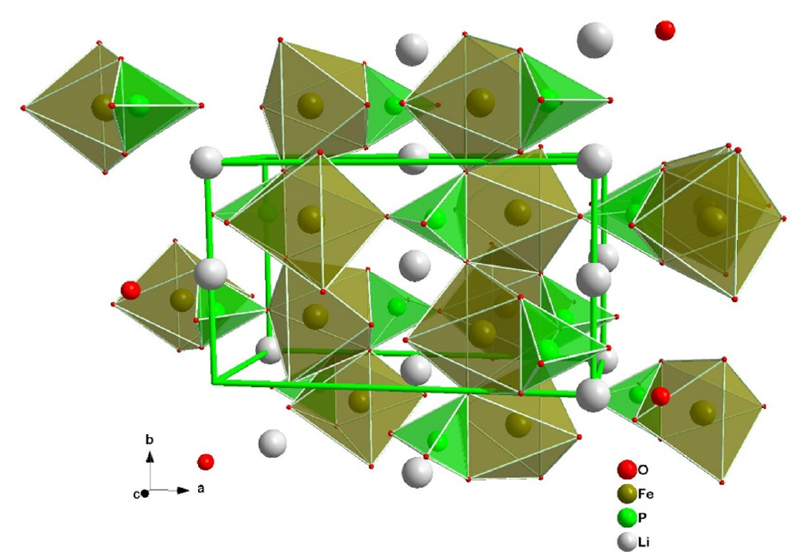
Figure 3. Orthorhombic crystal structure of LiFePO 4 (Olivine), space group